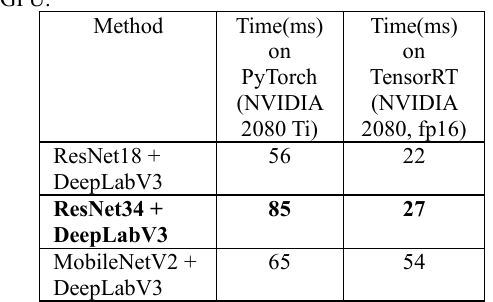
Table 6. Inference time for a 1,024×1,024 input on PyTorch